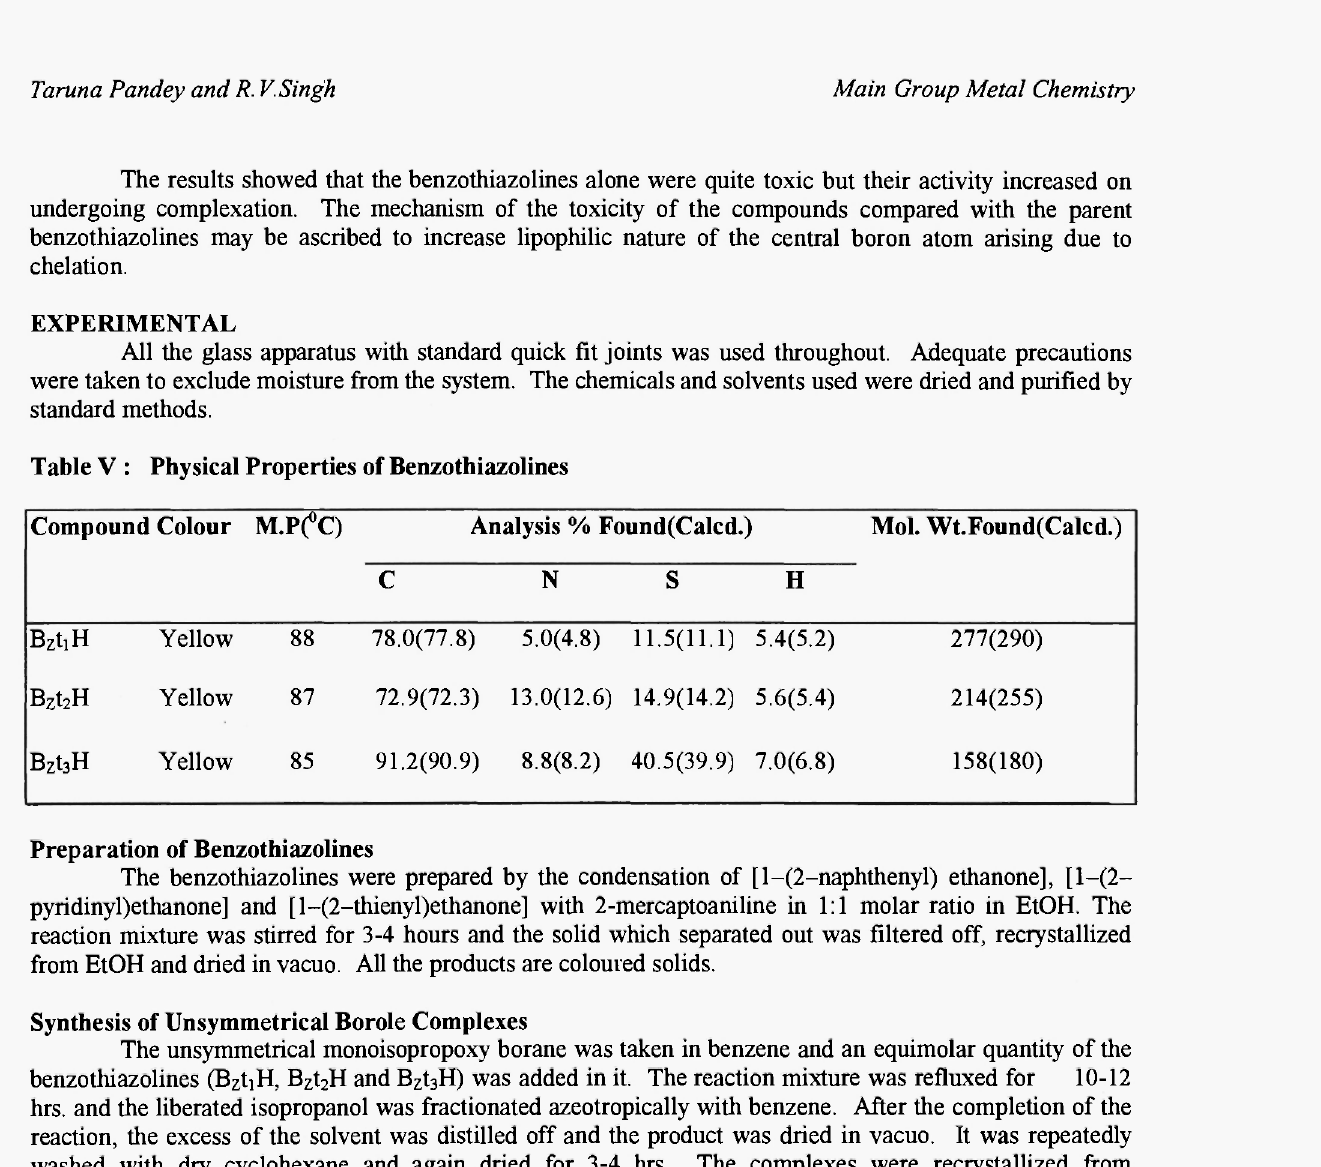
Physical Properties of Unsymmetrical Borole Complexes